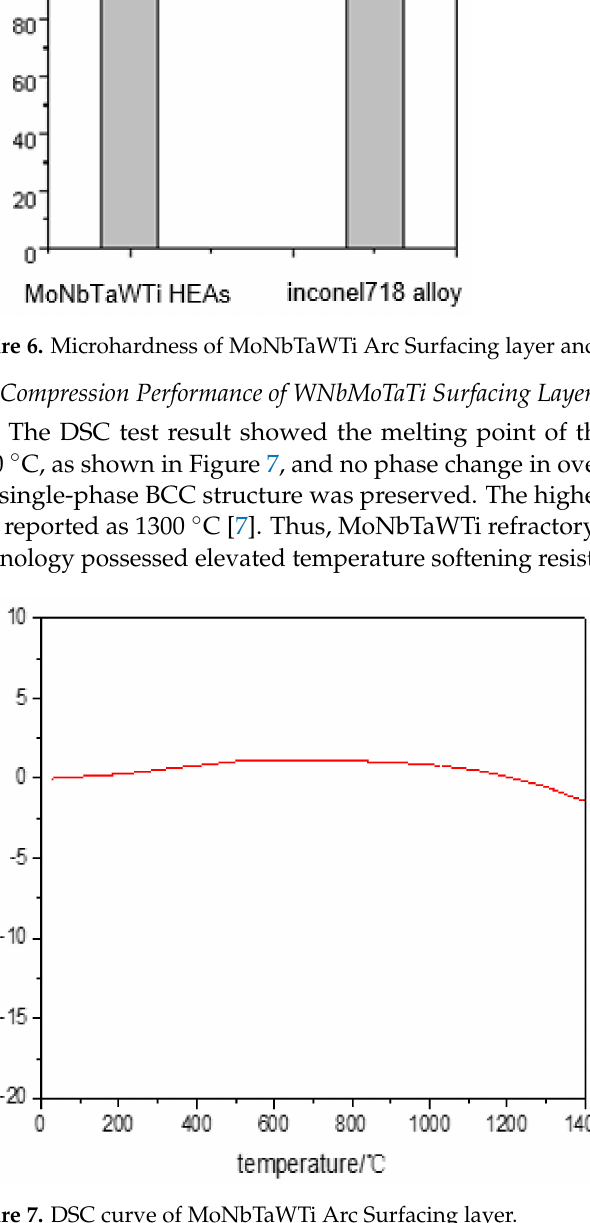
Figure 7. DSC curve of MoNbTaWTi Arc Surfacing